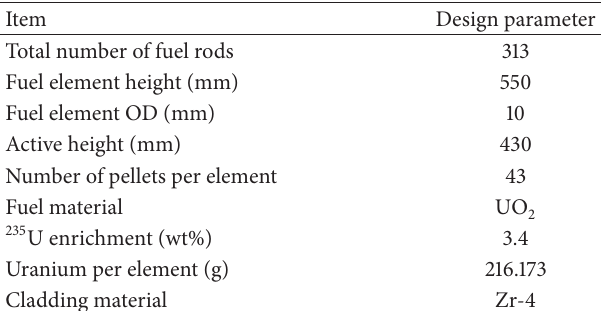
Figure 4: Schematic drawing of the JSA fuel rod. Table 1: JSA reactor fuel rod specifications.